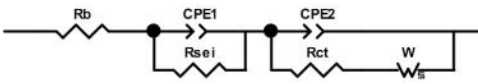
Figure 8. An equivalent circuit representing the electrode/electrolyte system.